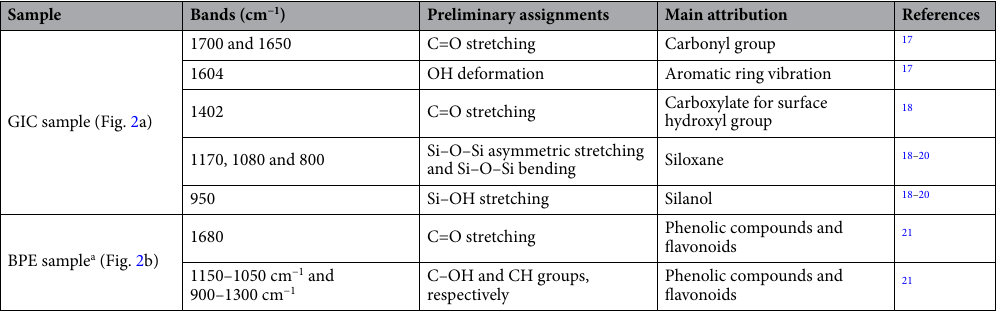
Table 1. The preliminary assignments of ATR-FTIR absorption spectra of GIC, BPE and GIC-BPE samples. a The broad absorption bands obtained from Schinus terebinthifolius Raddi represent the substantial overlap of absorption bands of various components with different